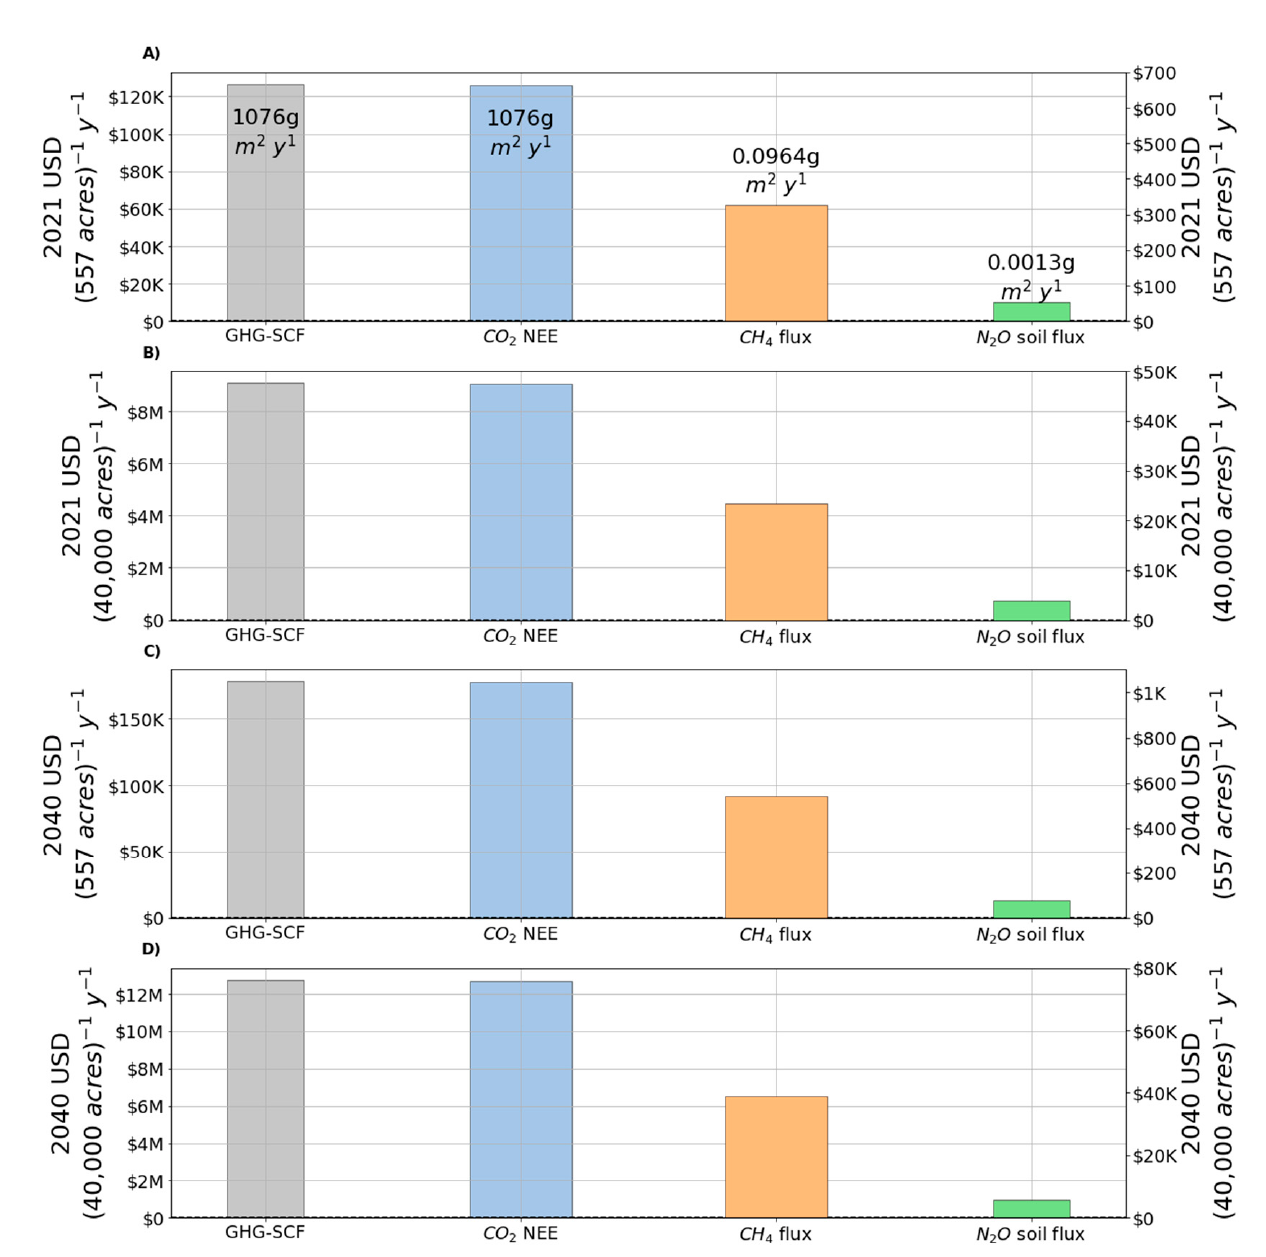
Figure 5. Greenhouse gas (GHG) social cost forest (GHG-SCF) yearly means (bars) for CO 2 (blue) and CH 4 (orange) fluxes measured at the top of the tower, N 2 O (green) fluxes measured at chambers no. 2 (CO 2 and CH 4 ) and no. 10 (N 2 O), and the total sum of the three (GWG economic value; gray). Soil flux averages correspond only to the period May–November, while the tower means to the full year. For illustration purposes, results were extrapolated to the Howland research area (557 acres; panels ( A , C ) and to 40,000 acres (panels ( B , D ). Social cost values (USD) used were ( A , B ) $52, $1500, and $19,000 per GHG metric ton of CO 2 , CH 4 , and N 2 O, respectively (values estimated for the year 2021). ( C , D ) $73, $2500, and $28,000 per GHG metric ton of CO 2 , CH 4 , and N 2 O, respectively (values estimated for the year 2040) [33]. In each panel, GHG-SCF Economic values and CO 2 NEE are represented by left Y-axes, while CH 4 and N 2 O fluxes by right Y-axes. In panel ( A ), yearly means capture is annotated for each gas in g m − 2 y − 1 above each bar.